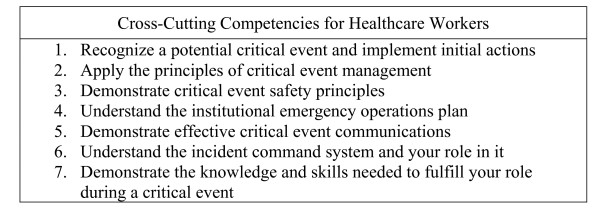
Cross-cutting competencies for healthcare workers.